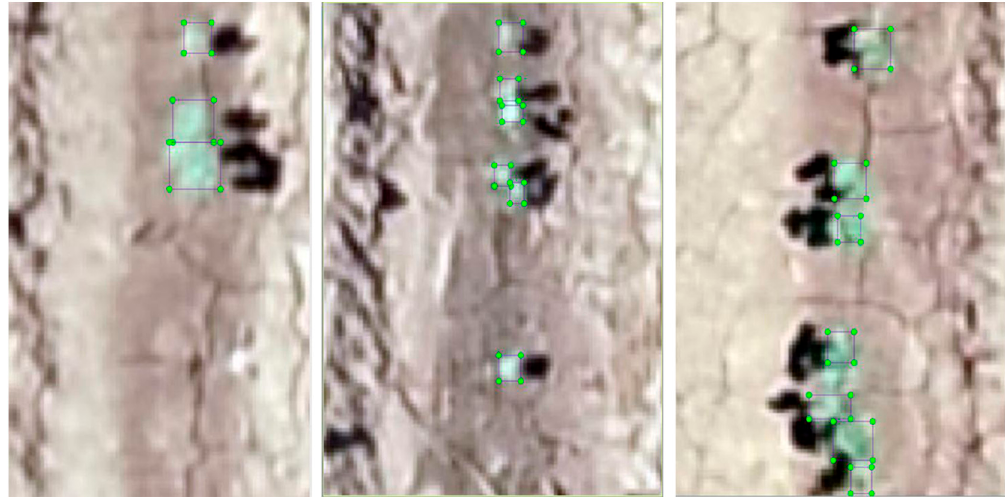
Figure 2. Sample training images showing cotton plants labeled as bounding boxes on unmanned aerial systems images for stand counting using deep learning algorithms.